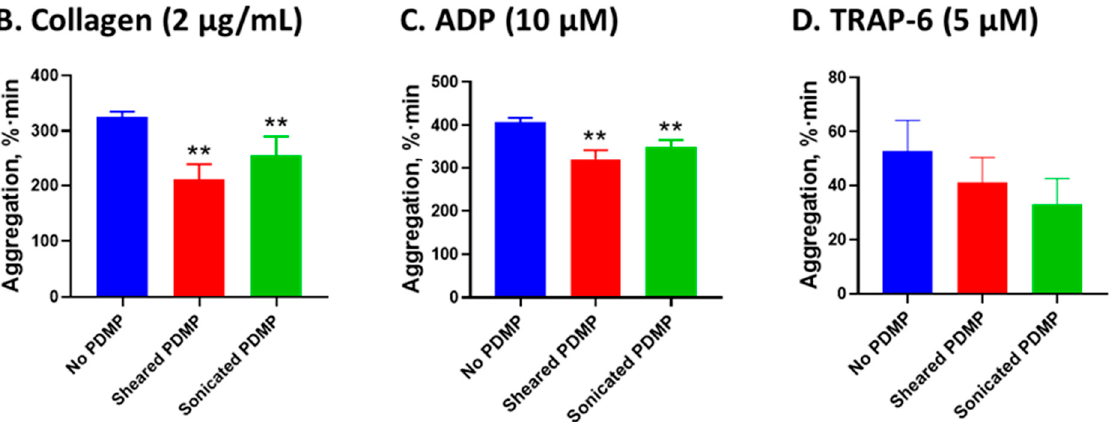
Figure 9. Platelet-derived microparticles (PDMPs) generated as a result of shear stress exposure and sonication inhibit agonist-induced platelet aggregation in plasma: ( A )—representative aggregation curves; ( B )—collagen-induced aggregation ( n = 7–14), ( C )—ADP-induced aggregation ( n = 7–18), ( D )—TRAP6-induced aggregation ( n = 4–10). Mean ± SEM, 1-way ANOVA followed by Dunnett multiple comparisons test: **— p < 0.01 vs. no